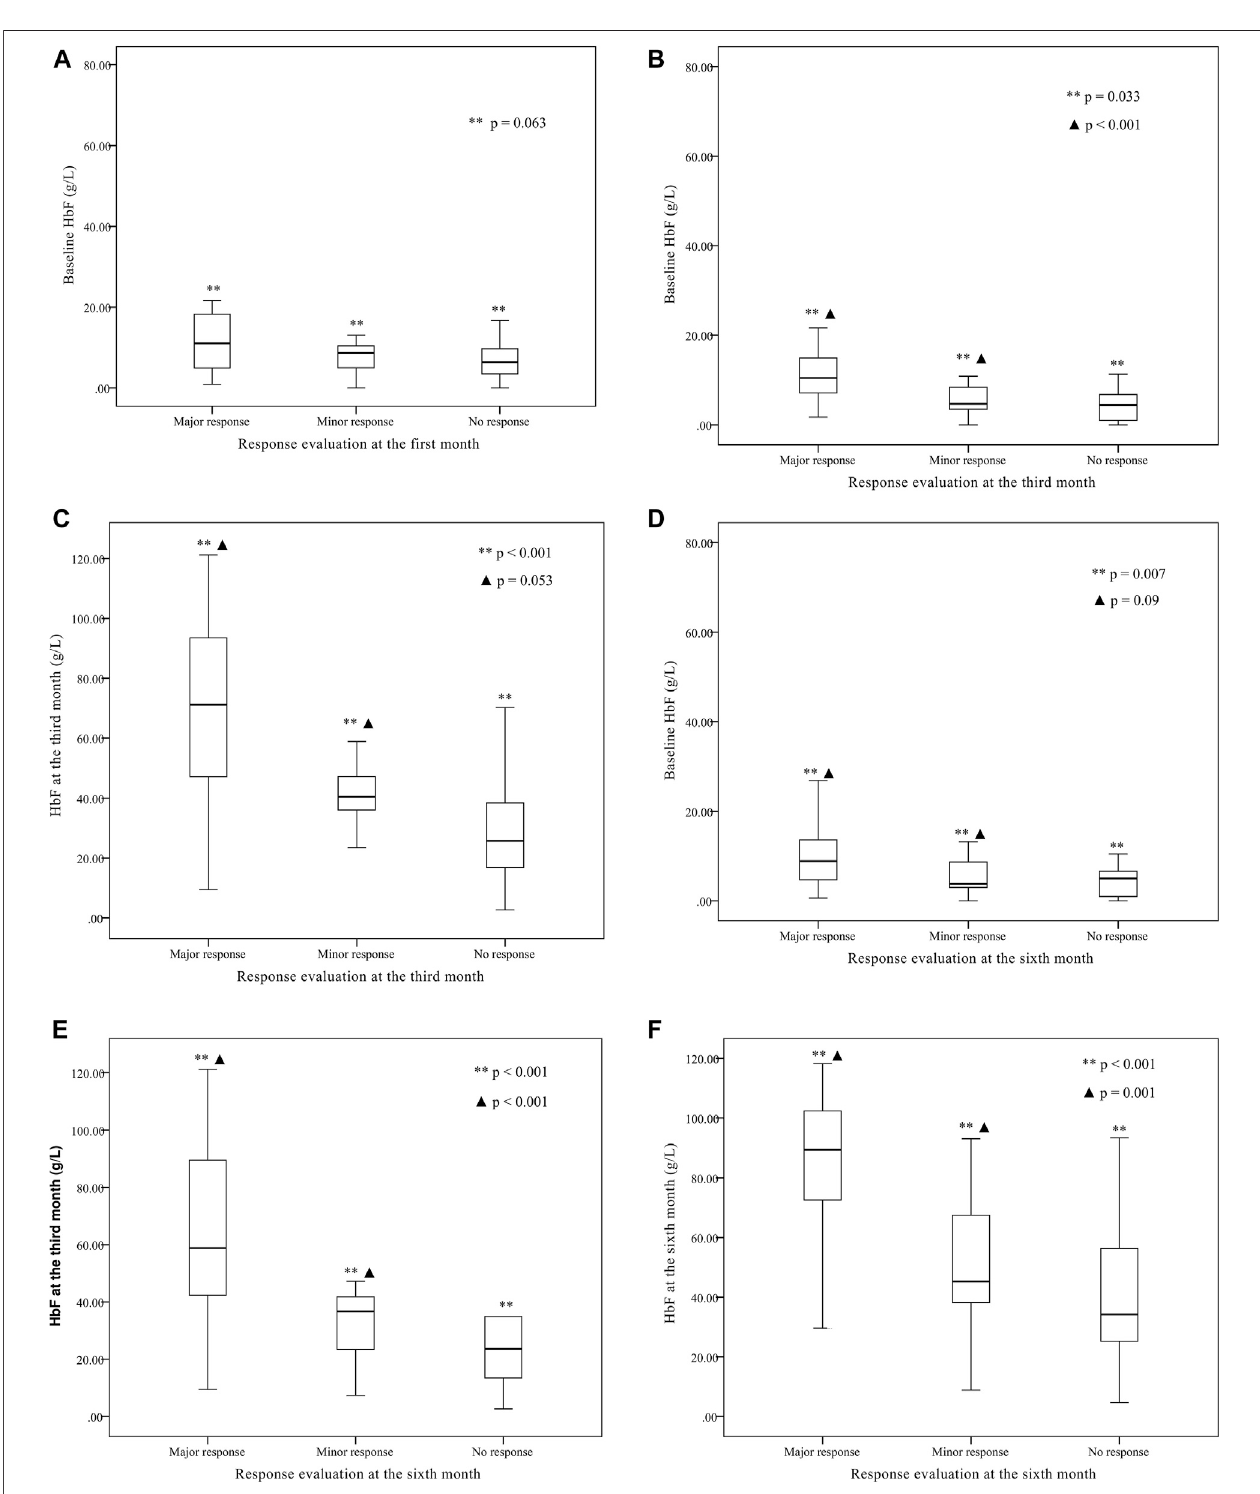
FIGURE 2 | The baseline fetal hemoglobin (HbF) concentration, HbF concentration at the third month of treatment, and HbF concentration at the sixth month of treatmentcomparisonbetweengroupsofmajorresponse,minorresponseandnoresponse. (A) ThebaselineHbFconcentrationwerenotsigni fi cantlydifferentbetween group major response (11.1 (1.7, 77.18) g · L-1), minor response (9.5 (3.58, 15.4) g · L-1) and group no response [6.3 (0.5, 38.4) g · L-1] (** p (cid:2) 0.063) according to the evaluation at the fi rst month. The differences between any two groups were not signi fi cant. (B) According to the evaluation at the third month, the baseline HbF concentration was signi fi cantly higher in group major response [10.4 (1.7, 77.18) g · L-1] than group minor response [5.32 (2.99, 7.64) g · L-1] and group no response